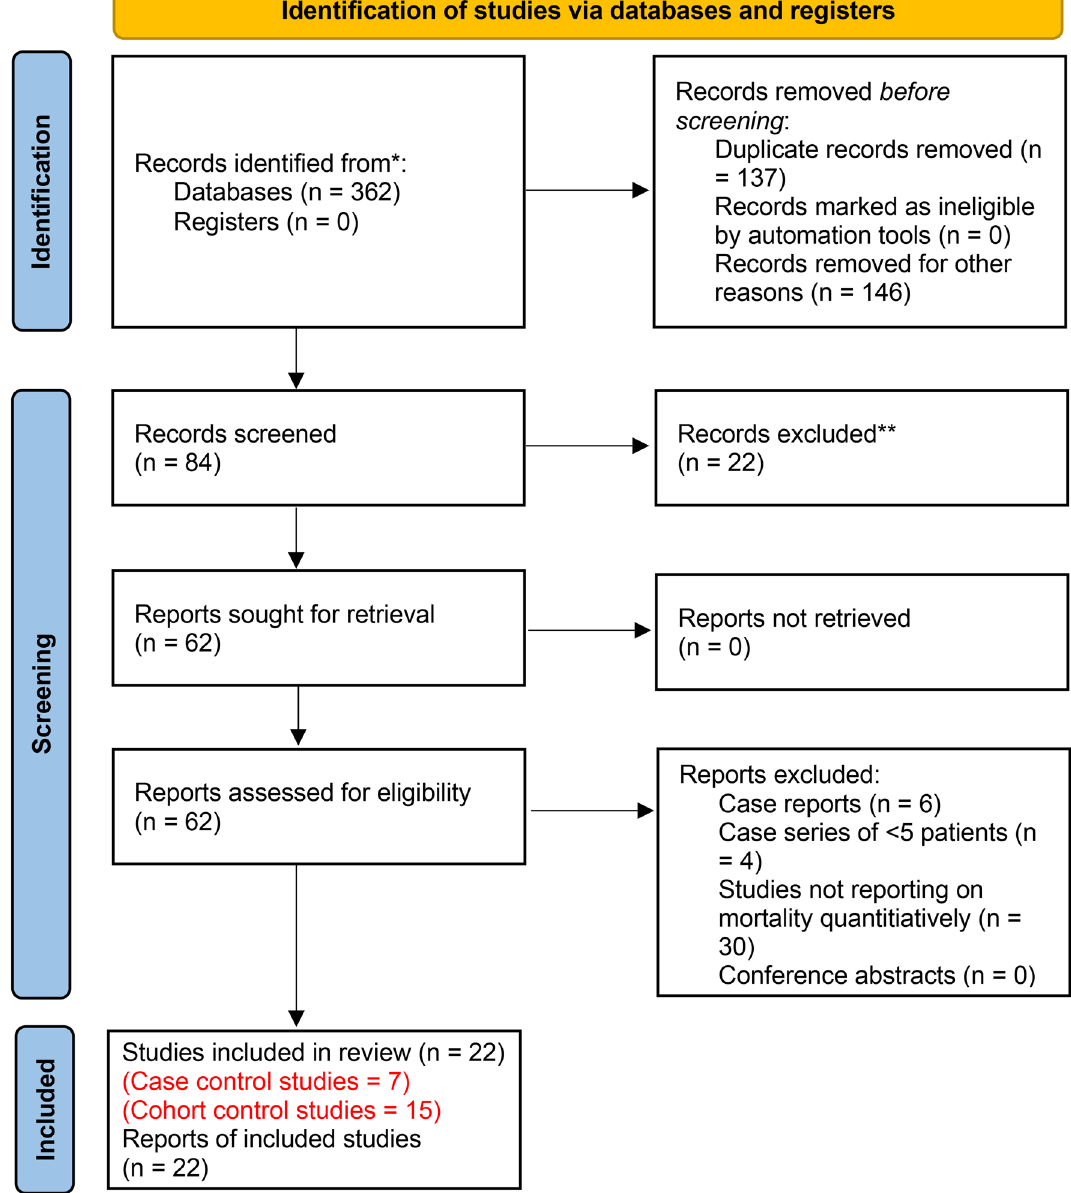
Figure 1. Shows the PRISMA diagram for the search strategy and study